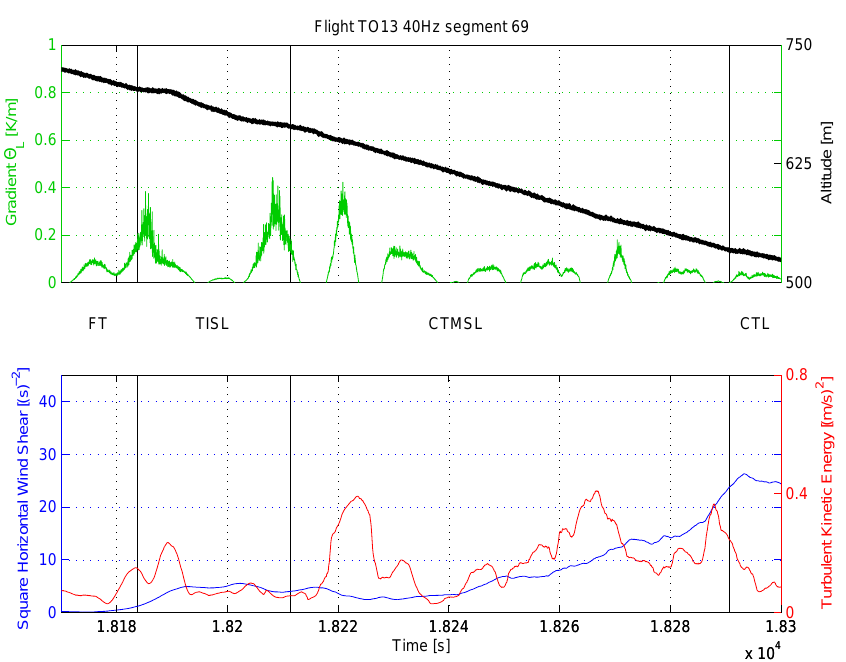
Fig. 13. As in Fig. 12 but for flight TO13. The flight segment corresponds to Fig. 8.